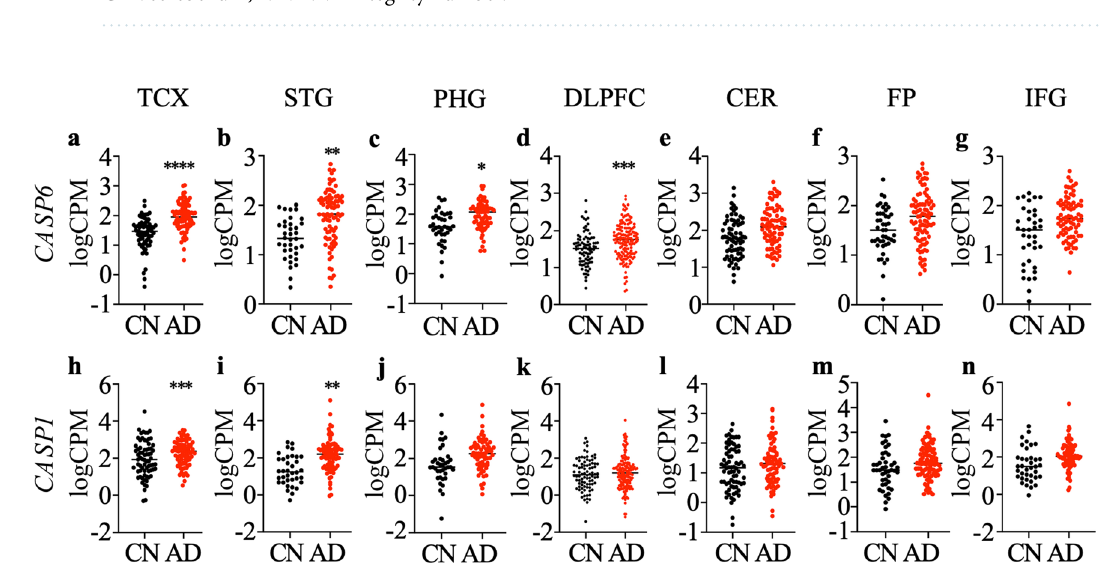
Figure 1. Differential expression of CASP6 and CASP1 in Alzheimer disease (AD) and cognitively normal (CN) brains. The logarithm of read counts per million total reads (logCPM) values for CASP6 mRNA ( a – g ) and CASP1 mRNA ( h – n ) generated from RNA-Seq data for AD and CN temporal cortex (TCX; a , h ), superior temporal gyrus (STG; b , i ), para-hippocampal gyrus (PHG; c , j ), dorsolateral prefrontal cortex (DLPFC; d , k ), cerebellum (CER; e , l ), frontal pole (FP; f , m ) and inferior frontal gyrus (IFG; g , n ). Each dot represents data from one individual and the horizontal bar denotes the mean. Statistical evaluations were done with the R package limma between AD and CN. *P < 0.05, **p < 0.01, ***P < 0.001, ****p < sex, mean age at death, and apolipoprotein APO E genotype of the participants used for differential gene expres- sion analysis in each brain region are summarized in Table 1. The RNA integrity number (RIN) where 10 repre- sents intact RNA and 1 completely degraded RNA ranged from 6.3 to 8.7. Gene expression association analysis using RNA-Seq data generated from temporal cortex (TCX), para-hippocampal gyrus (PHG), inferior frontal gyrus (IFG), superior temporal gyrus (STG), frontal pole (FP), dorsolateral prefrontal cortex (DLPFC), and cerebellum (CER) identified that CASP6 mRNA was up-regulated in the TCX (Fig. 1a), STG (Fig. 1b), PHG (Fig. 1c), and DLPFC (Fig. 1d) of AD compared to cognitively normal older adults. Levels in the CER (Fig. 1e), FP (Fig. 1f), and IFG (Fig. 1g) were not significantly different. Casp6 is activated by Caspase-1 (Casp1), there- fore CASP1 mRNA levels were also evaluated. CASP1 mRNA levels were significantly up-regulated in AD TCX (Fig. 1h) and STG (Fig. 1i), but not in PHG (Fig. 1j), DLPFC (Fig. 1k), CER (Fig. 1l), FP (Fig. 1m), or IFG (Fig. 1n), compared to cognitively normal older adults. Recombinant Caspase‑6 N73T (Casp6N73T) zymogen showed similar self‑processing as Cas‑ pase‑6 wild type (Casp6WT) zymogen. To observe the self-processing of Caspase-6 N73T (Casp6N73T) zymogen, recombinant protein from three independent clones expressing Casp6N73T zymogen were compared with Caspase-6 wild type (Casp6WT) zymogen and catalytically inactive triple mutant Casp6D(23,179,193) A. The Casp6WT zymogen undergoes self-processing at D23, D179, and D193 to remove the pro-domain and the inter-subunit linker, which allows the formation of active Casp6 consisting of two large subunits (LS) and two small subunits (SS) (Fig. 2a). Purified recombinant Casp6N73T and Casp6WT zymogens both generated the expected small subunit (SS) and large subunit with (LSL) or without (LS) inter-subunit linker. Casp6WT